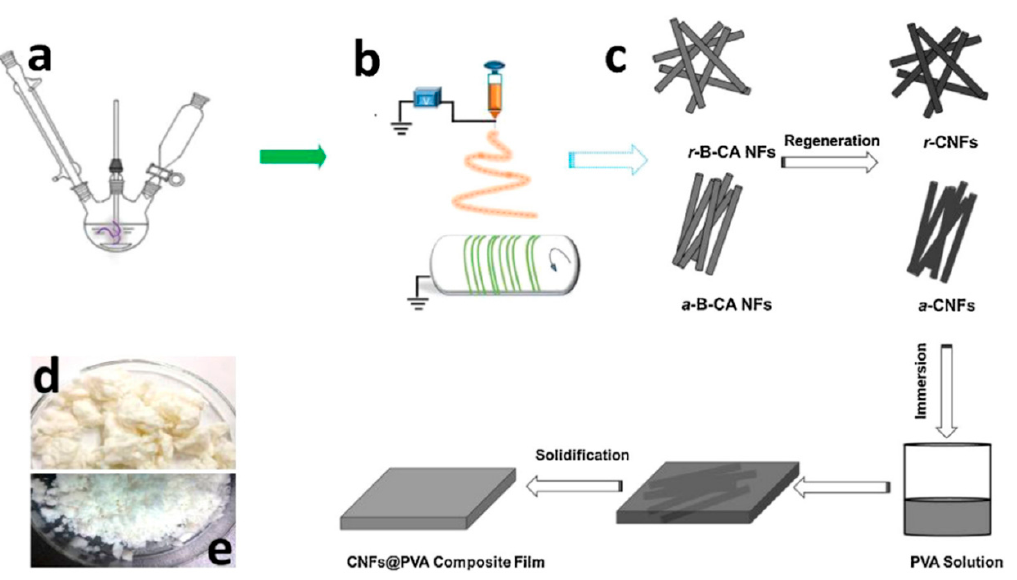
Figure 5. Schematic illustration of ( a ) acetylation reaction, ( b ) electrospinning, ( c ) CNFs@PVA composite films preparation process, and ( d , e ) photographs of bamboo cellulose (BC) and B-CA (Adapted from [61] ). CA: cellulose acetate, PVA: polyvinyl alcohol (Adapted from [61] ).